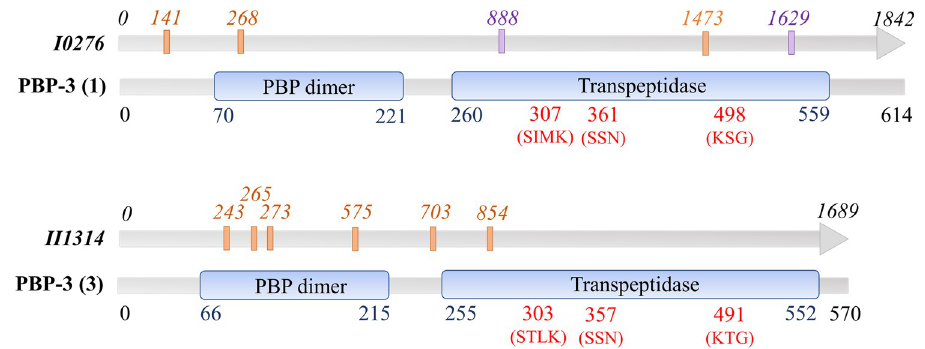
Fig 1. DLST scheme based on 11 nucleotides in two genes ( I0276 and II1314 ) encoding putative PBP-3s. Nucleotide positions are based on sequence alignment to the B . pseudomallei 1026b reference strain. Nucleotides with phylogeographic utility (orange font) and utility for differentiating closely related Burkholderia species (purple font) are shown. PBP conserved domains (blue bubbles), amino acid position of domains (blue font), active site residues and positions (red font).